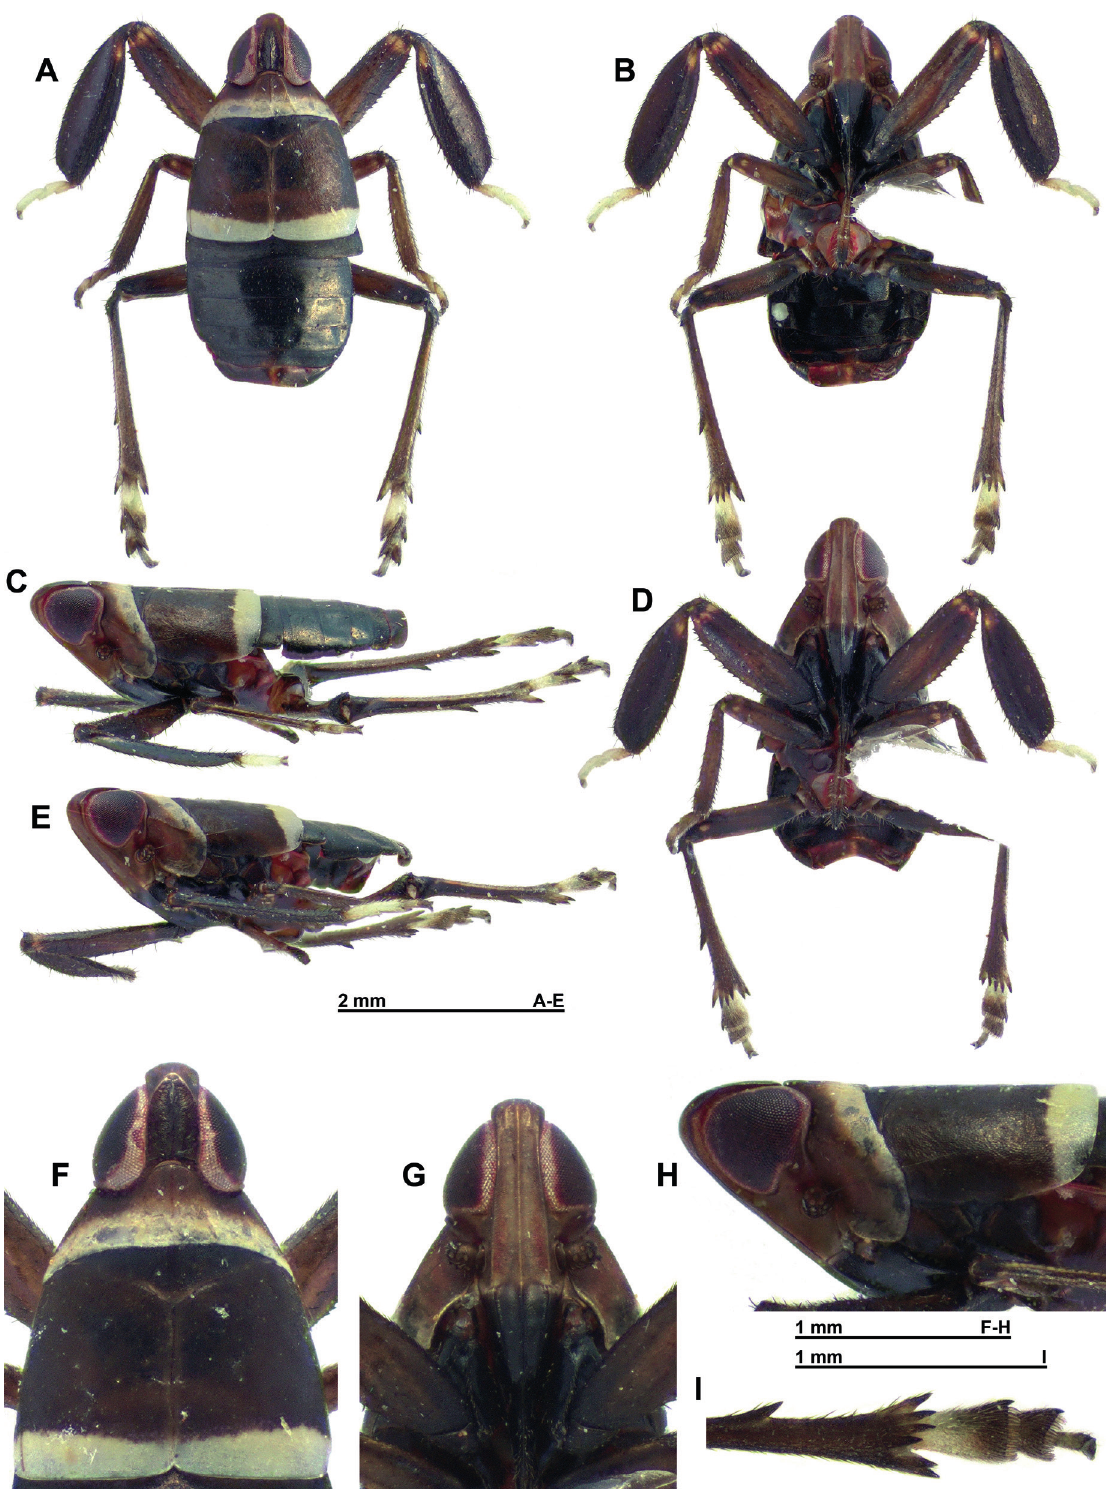
Fig. 2. Cleotyche ( Cleotyche ) christinae sp. nov., ♂, holotype (QM). A . Habitus dorsal view. B . Habitus, ventral view. C . Habitus, lateral view. D . Habitus, perpendicular view of frons. E . Habitus, anterolateral view. F . Head and thorax, dorsal view. G . Frons, perpendicular view. H . Head and thorax, lateral view. I . Distal portion of posterior leg, ventral